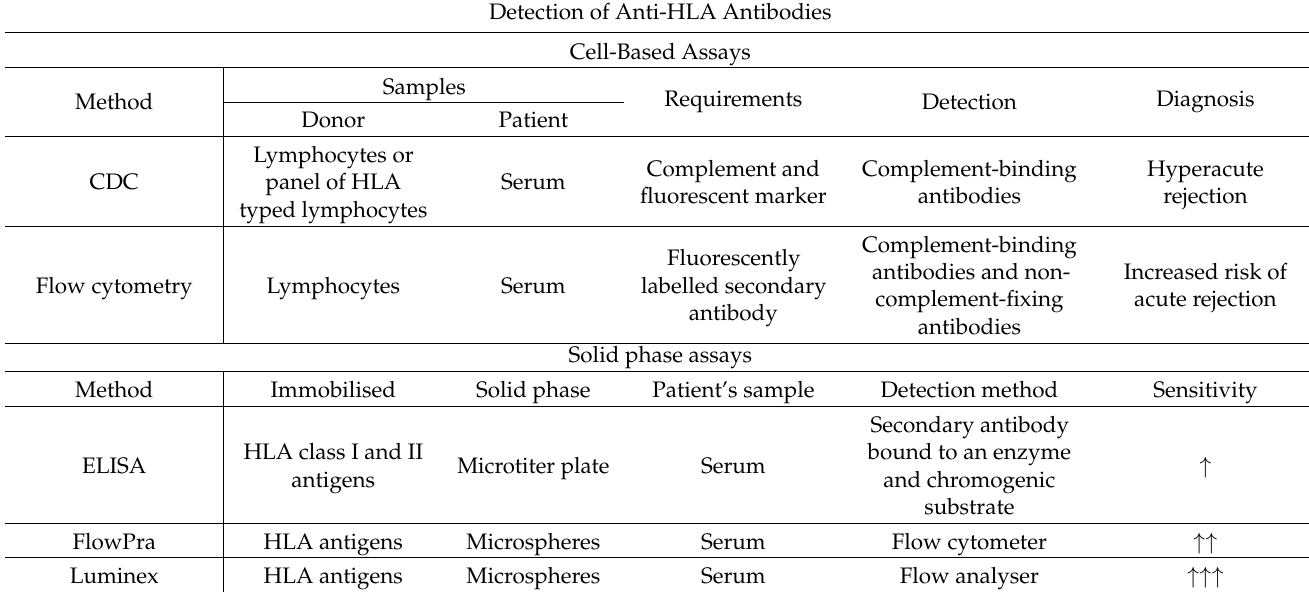
Table 1. Methods to detect anti-HLA antibodies. Detection of Anti-HLA